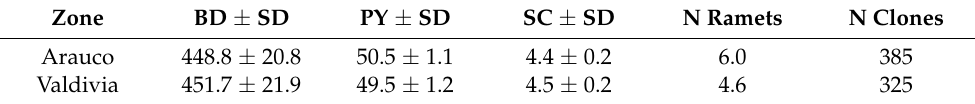
Table 3. Summary of wood properties measurements for a clonal population of E. nitens x E. globulus at 6 years. BD = Basic Density (kg/m 3 ), PY = Pulp Yield (%), SC = Specific Consumption (m 3 /ADt), N Ramets = number of ramets per clone sampled, and N Clones = number of clones evaluated. Zone BD ± SD PY ± SD SC ± SD N Ramets N Clones Arauco 448.8 ± 20.8 50.5 ± 1.1